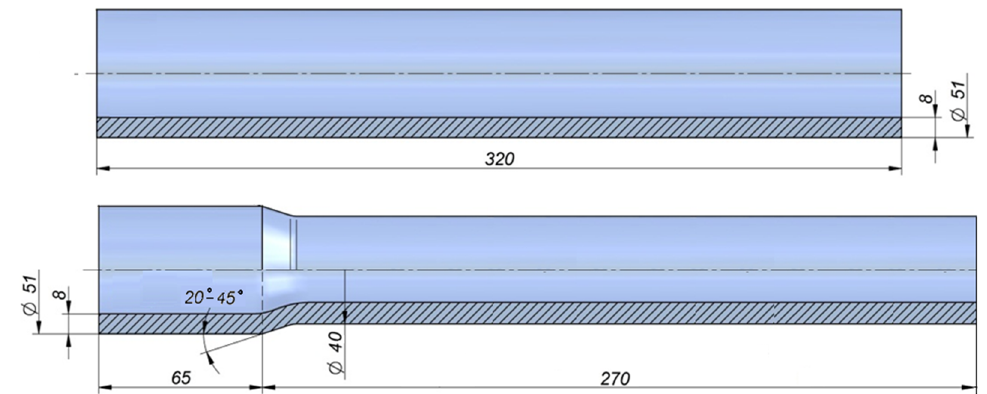
Figure 2. Hollow billet and the example of finished part (dimensions in mm).